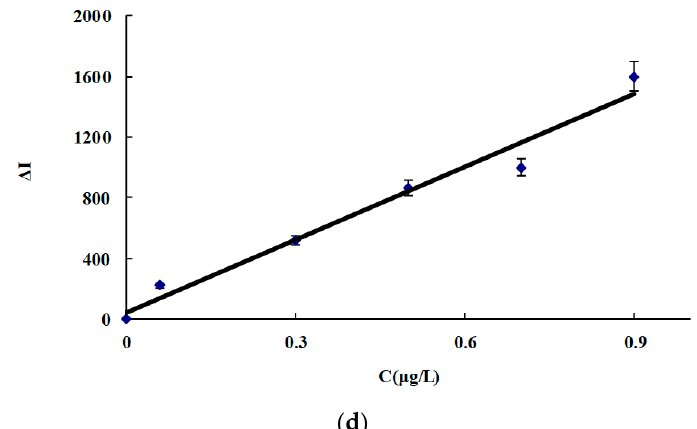
Figure 5. Working curve for ACT. ( a ) CD N system, ( b ) CD NAg1 system, ( c ) CD NAg2 system, and ( d ) CD NAg3 system. Table 3. Analytical characteristics of the carbon dot (CD) catalytic amplification surface-enhanced Raman scattering (SERS) assay for acetamiprid (ACT).